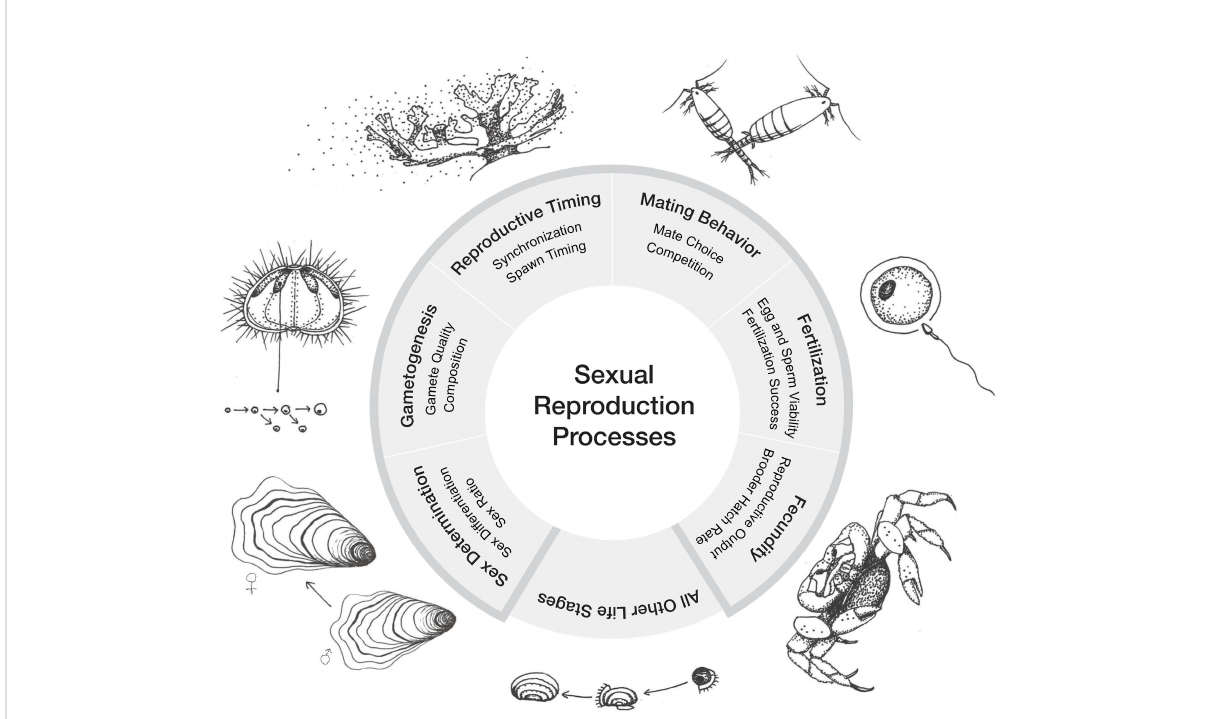
FIGURE 1 Sexual reproduction processes in marine invertebrates. The six processes discussed in this review are presented clockwise beginning with Sex Determination. Sex determination is the initial event that determines whether the gonads will develop as testes or ovaries and has great importance to the consideration of sex ratios, particularly for non-hermaphroditic species. Mechanisms for sex determination can be genetic or environmental. Sex differentiation is the development of sex differences after determination. Gametogenesis is the process of gamete formation which can lead to gametes with different characteristics (i.e., size, reserves, viability). Reproductive timing includes synchronization of gamete development, spawning, and any other reproductive process. Mate selection, courtship display, and mate guarding are common mating behaviors. Fertilization success depends on gamete quality, reproductive timing, mating behavior and synchronization. Fecundity is a measure of reproductive potential of an